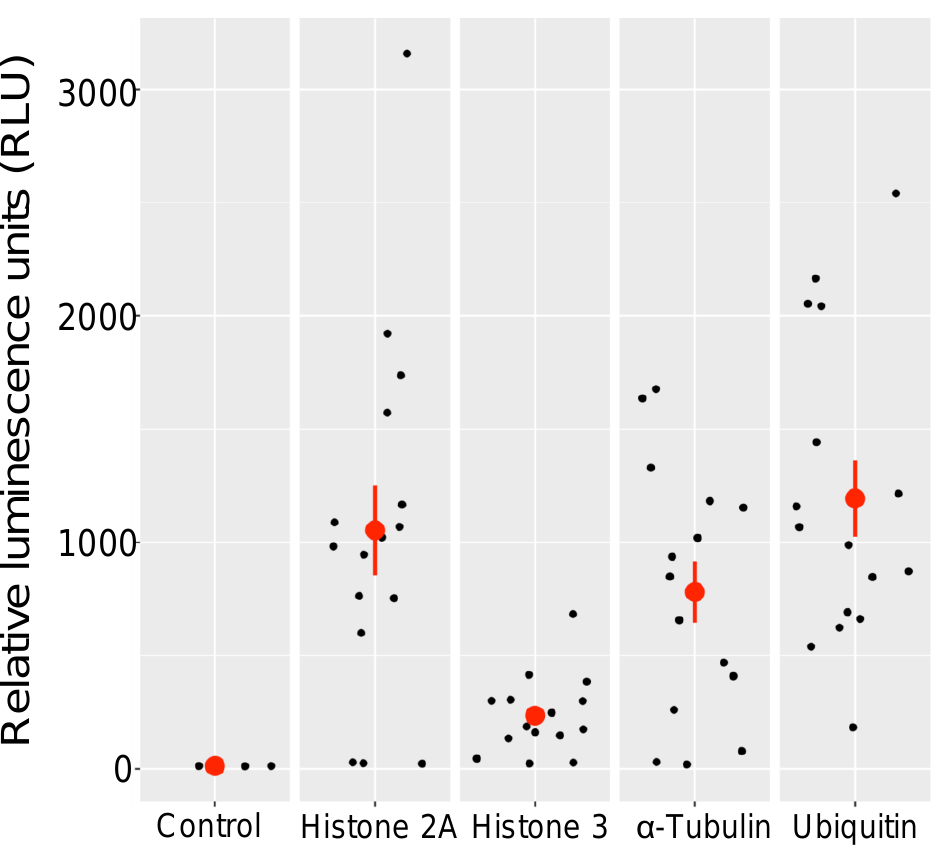
Figure 5. Emission of light from transgenic lines expressing luciferase. Promoters from highly expressed genes were compared (16 independent transformants were tested for each construction): Control: background level of fluorescence from four independently grown non-transformed lines, pOLK2–Histone 2A (P_H2A), pOLK3–Histone 3 (P_H3), pOLK1– α -Tubulin (P_aTub), pOLK4–Ubiquitin (P_Ub). The raw data are available in Table S3. To compare between constructs, we preferred to plot the relative bioluminescence units (ordinate) from each transformant as jittered points [69] (“geom_jitter” ggplot2 function in R). The means and standard errors for each construct are shown as large red dots and vertical bars, respectively.